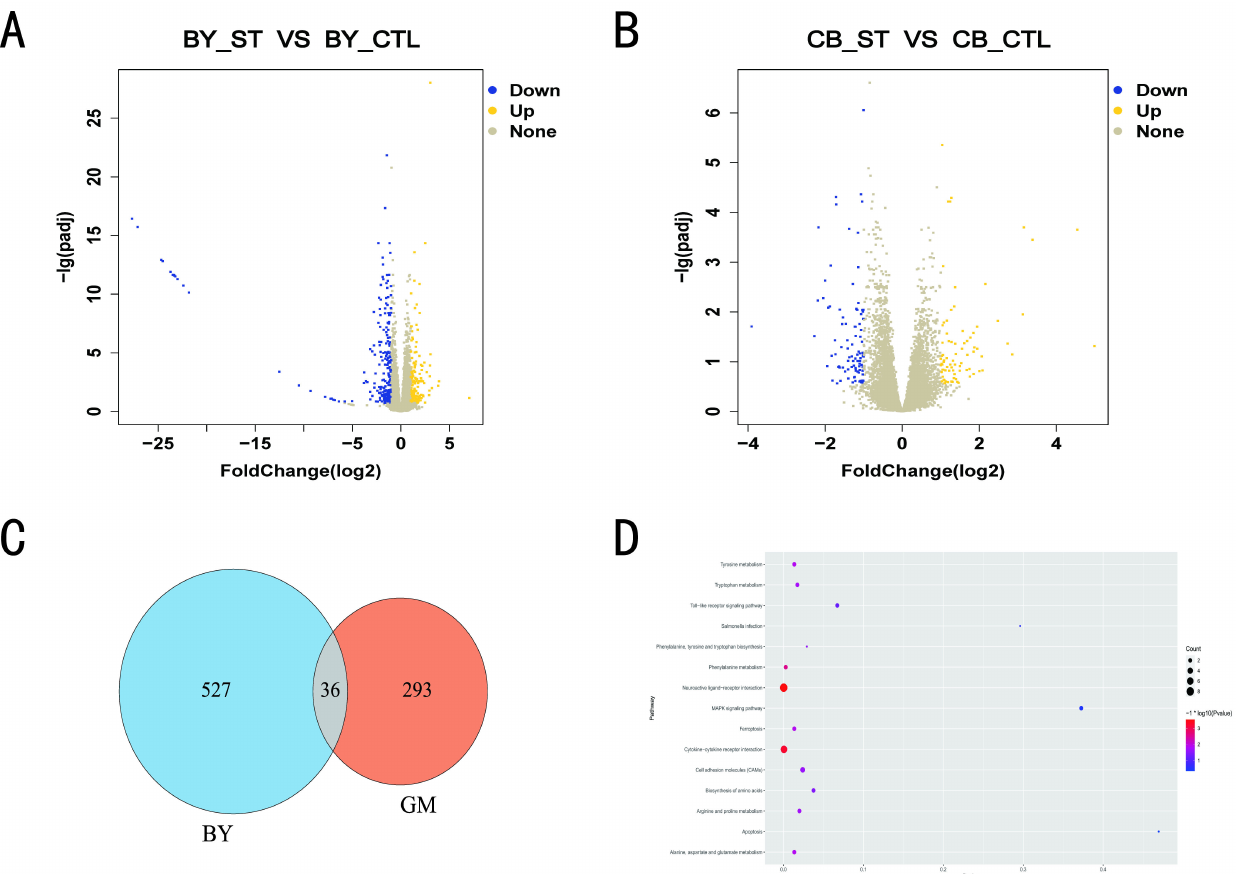
Figure 2. Liver transcriptome profile comparison between the ST and control group in BY and GM. ( A ) Volcano plot of DEGs in BY. Blue spots represent downregulation, and yellow spots represent upregulation (log2 FC ≥ 1 and Q < 0.05). ( B ) Volcano plot of DEGs in GM. Blue spots represent downregulation, and yellow spots represent upregulation (log2 FC ≥ 1 and Q < 0.05). ( C ) Venn diagram of differentially expressed genes in BY and GM. ( D ) KEGG signaling pathway enrichment analysis of genes significantly differentially expressed only in GM ( p < 0.05). At 28 days, liver tissue samples from 8 randomly selected chickens in each group were subjected to transcriptome